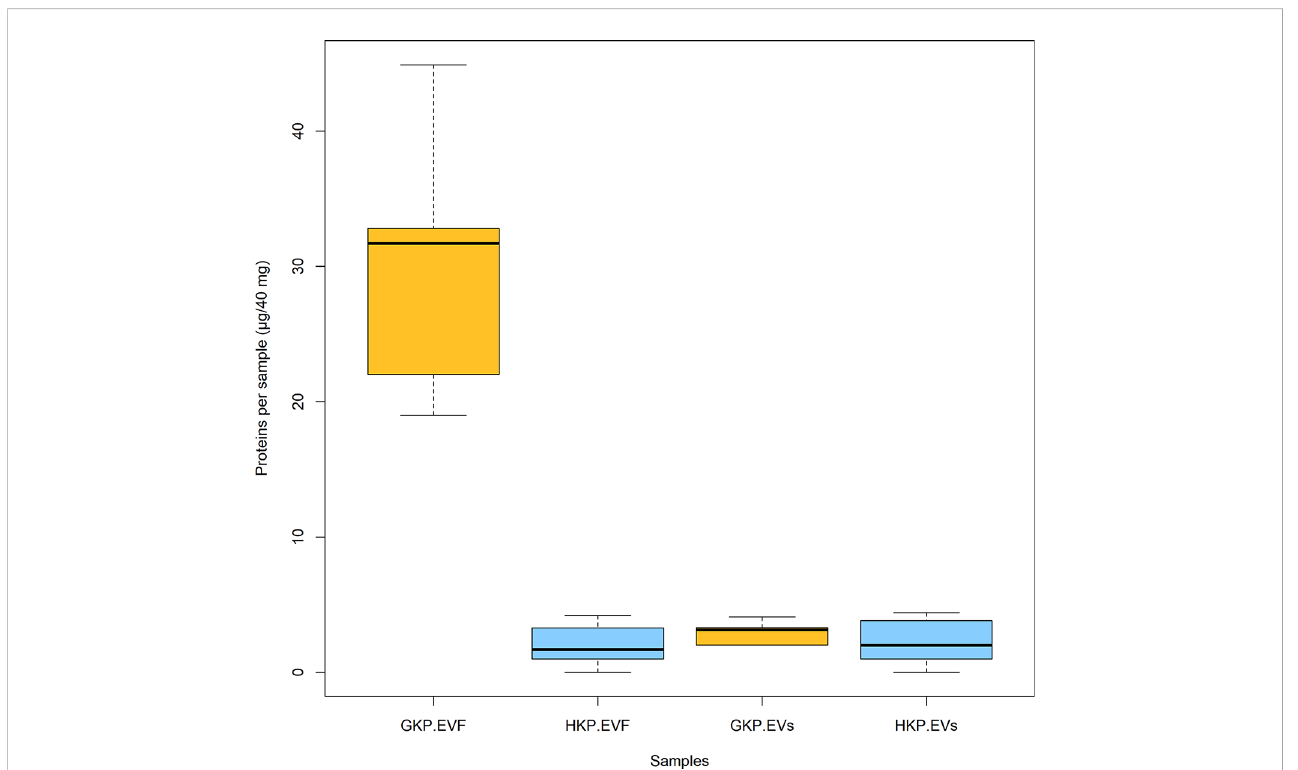
FIGURE 4 Mean protein content (± SD) for EVs and EVF from germinated and hydrated samples. Samples with different superscript letters were signi fi cantly different (p-value<0.05) by two-way ANOVA and Student